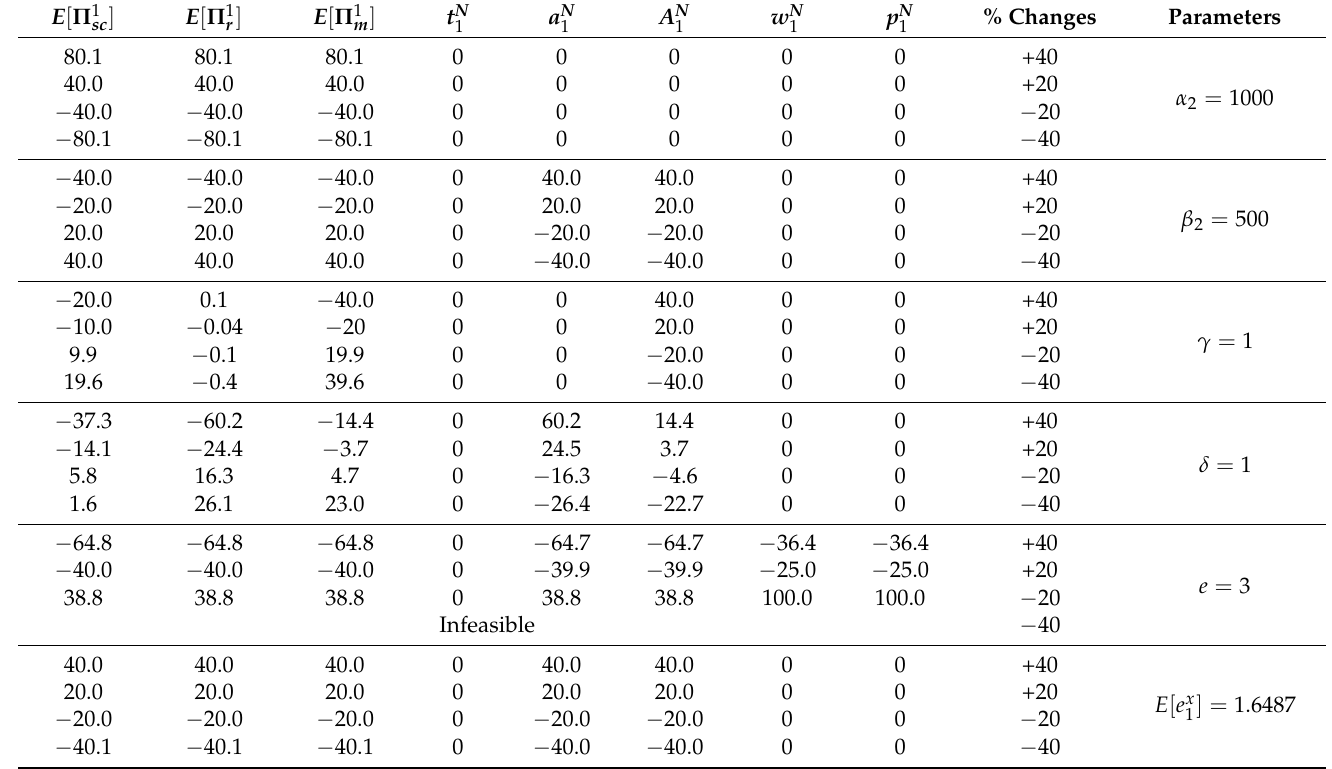
Table 7. The results of the sensitivity analysis in the Nash game for the first